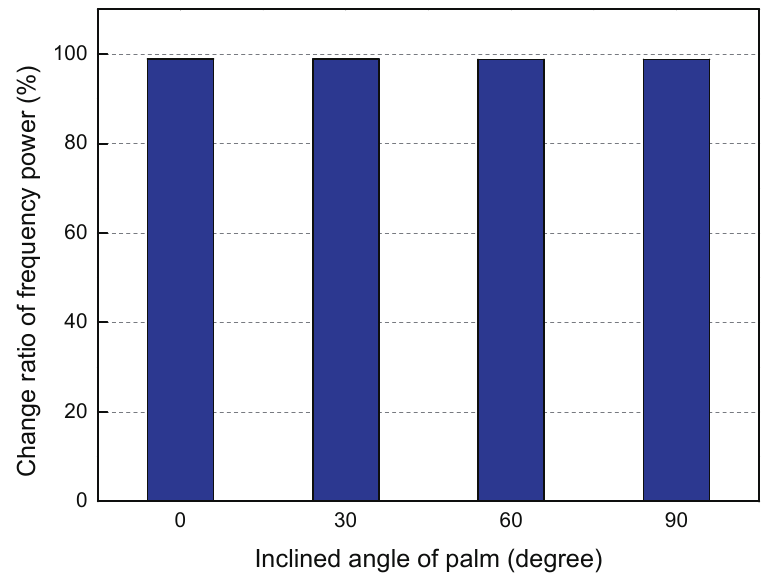
Figure 14. Different inclined angles of palm.